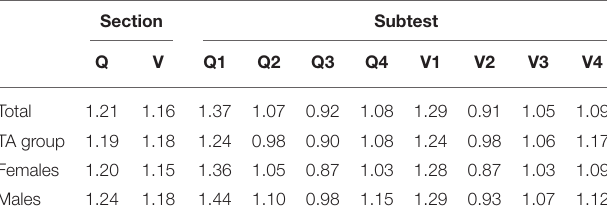
TABLE 5 | Value added ratio (VAR) for the population, the TA group, females and males based on test administration 16B.